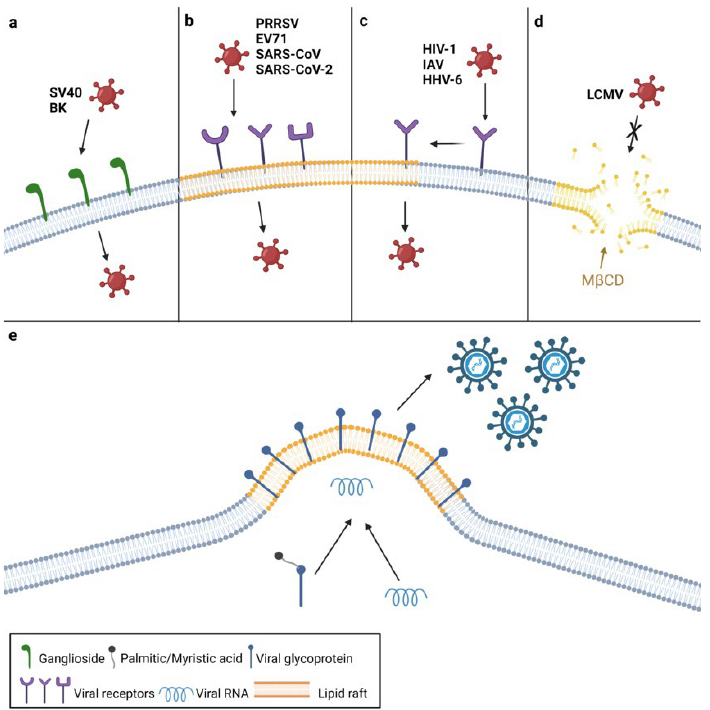
Figure 1. Roles of lipids during viral entry. ( a ) Lipids as viral receptors. Viruses such as polyomaviruses can interact with gangliosides on the cell surface and utilize them for entry into the cell. ( b ) Lipid rafts as gathering sites for viral receptors. Some viruses bind to receptors, which are located at the lipid rafts. ( c ) Viral receptors are translocated to the lipid rafts after virus binding. Some viruses bind to non-raft receptors and induce their translocation to lipid rafts, which facilitate internalization. ( d ) Role of non-raft lipids in viral entry. Arenaviruses require non-raft cholesterol in the plasma membrane for entry into the cell. Sequestering of cholesterol using M β CD enables arenaviruses to enter the cell. ( e ) Roles of lipids during viral assembly and budding. Some viral proteins require myristoylation or palmitoylation (black) to target the lipid membrane, into which they are incorporated. Assembly of newly synthesized virions of some viruses occurs through lipid rafts. Created with